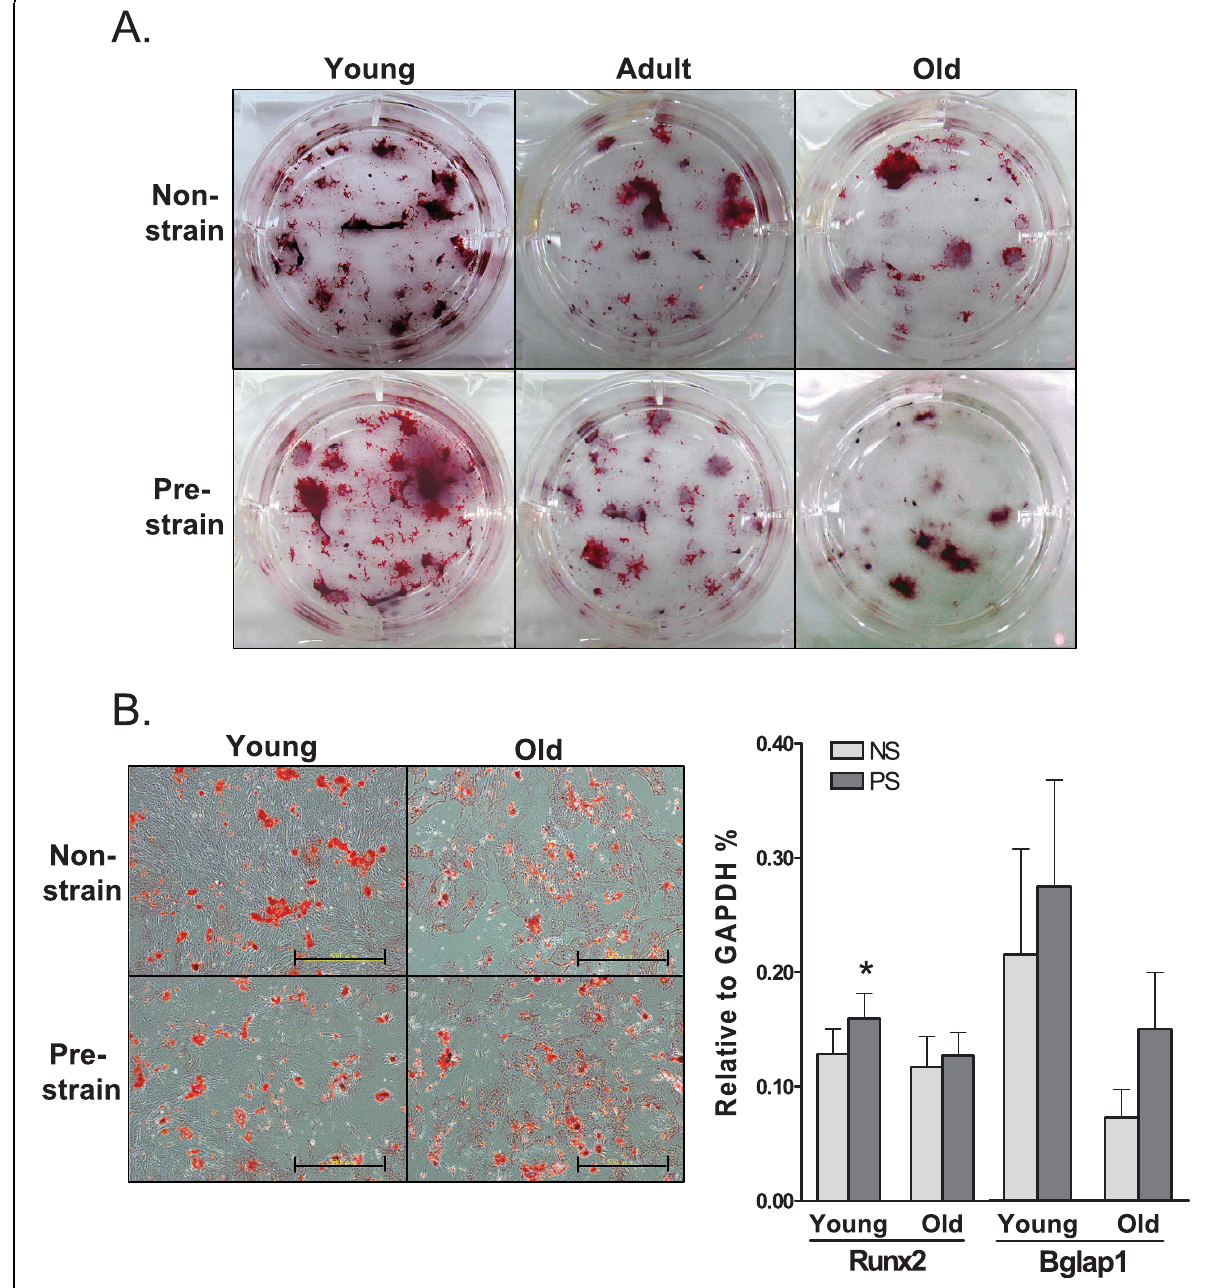
Figure 4 A. ARS staining for calcium deposition in osteogenically-induced young, adult, and old ADSCs with or without pre-exposure to mechanical strain . B . Left Osteogenic colonies from young and old ADSCs with or without pre-strain. Young ADSCs have stronger ARS staining than old cells. No difference in ARS staining caused by pre-strain was found. Scale bars = 500 μ m. Right The expression of Runx2 and Bglap1 in young and old ADSCs with or without pre-strain. N = 8. *: P < 0.05, compared to non-strained young